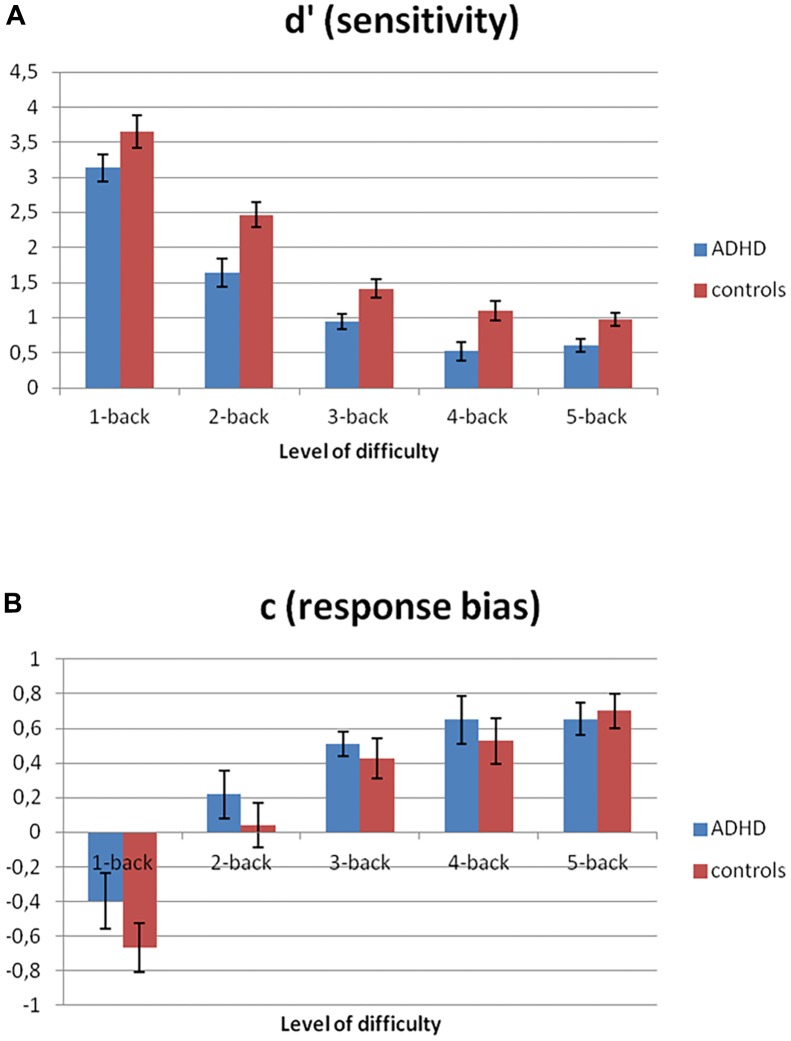
Performance on N-back task. Participants with ADHD (A) are overall worse at distinguishing target from non-target letters (d’) and (B) have similar response bias (c) toward choosing “non-target letter” with increasing task difficulty.